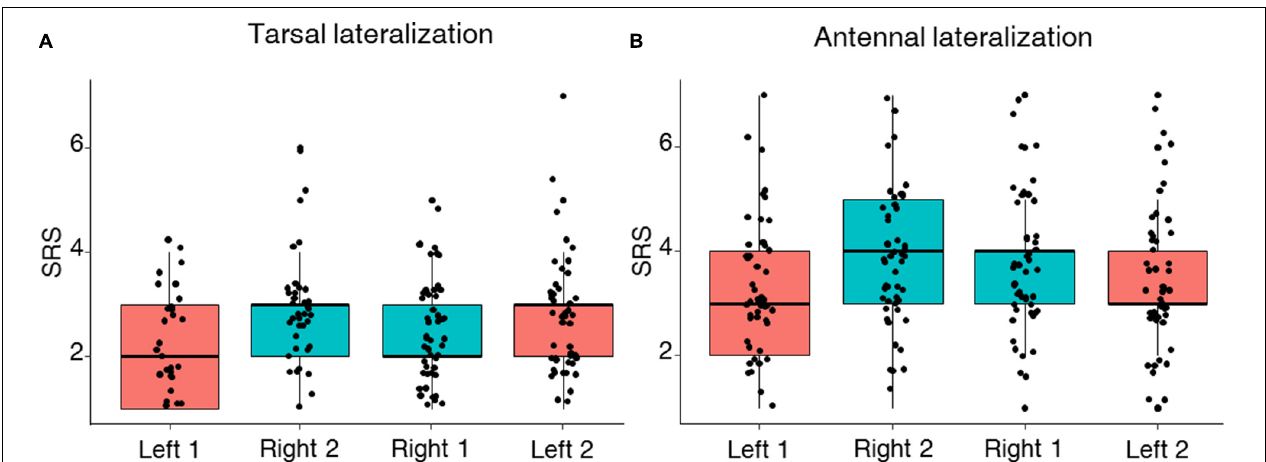
FIGURE 3 | Left–right tarsal (fore-tarsi) (A) and antennal (B) individual sucrose response scores (SRS). Median, quartiles, and max and min (upper and lower whiskers) SRS values of bees stimulated with seven sucrose solutions of increasing concentration (from 0.1 to 50% w/w) on the left (reddish) and the right (cyan) antenna and tarsus. Black dots represent individual bees. For each bee, SRS values could range between 7 (a bee responding to all seven concentrations) and 1 (a bee responding only to the highest concentration of 50%). (A) No lateralization of sucrose sensitivity was found at the level of the tarsi (LMM, n = 88, p = 0.29) while the order of testing had a significant effect (LMM, p = 0.001). (B) SRS revealed a lateralization of sucrose sensitivity (LMM, n = 101, p = 0.0001) while the order of testing had no effect (LMM, p =